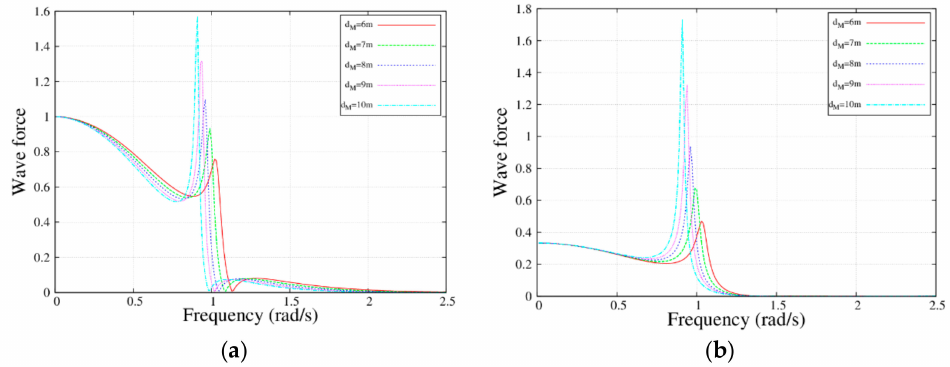
Figure 4. Wave load with the frequency for the MP and the WEB with di ff erent draft; d M = 6, 7, 8, 9 E = 10 m; and ( b ) F E = 10 and 10 m. ( a ) F M , R M B , R M